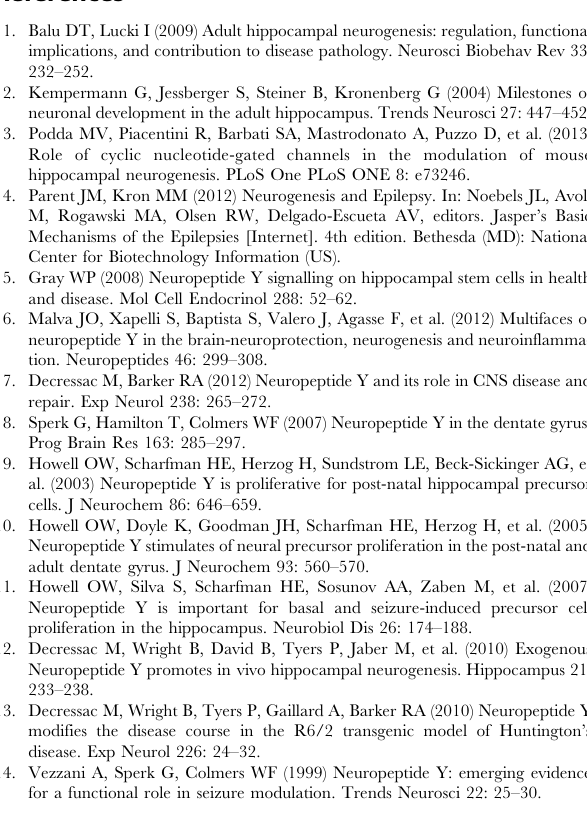
Table S2 Cell count results of double-stained BrdU/ NeuN positive cells. The table indicates the values of the total numbers of BrdU/NeuN double-stained cells 6 SD in the DG granular layer of the different experimental groups. Statistical analysis showed that the number of BrdU/NeuN double-labelled cells was significantly higher in TMT + NPY-treated rats compared with both CTRL groups (Two-way ANOVA, F 1,8 =32.5 p , 0.001) and TMT + saline group (Two-way ANOVA, F 1,8 = 5.37 p , 0.05). Table S3 Mean D Ct values, SD, SEM and p values referred to qPCR analysis. Table S3 shows the values of mean D Ct, SD, SEM and p referred to qPCR analysis of Shh, Ptch1, Ccnd1, Kif3a gene expression performed 1, 3 and 5 days after NPY treatment (A, B, C) and to Klf9 and Cdk5 gene expression performed 30 days after NPY treatment